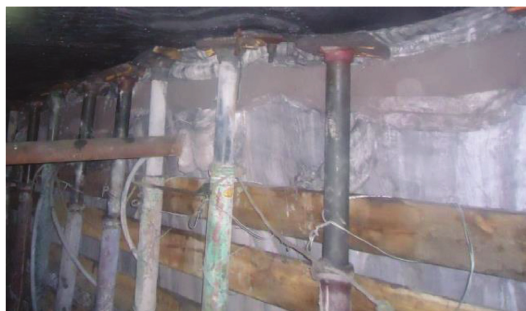
Figure 10: The effect of the filling body in the mold bag after